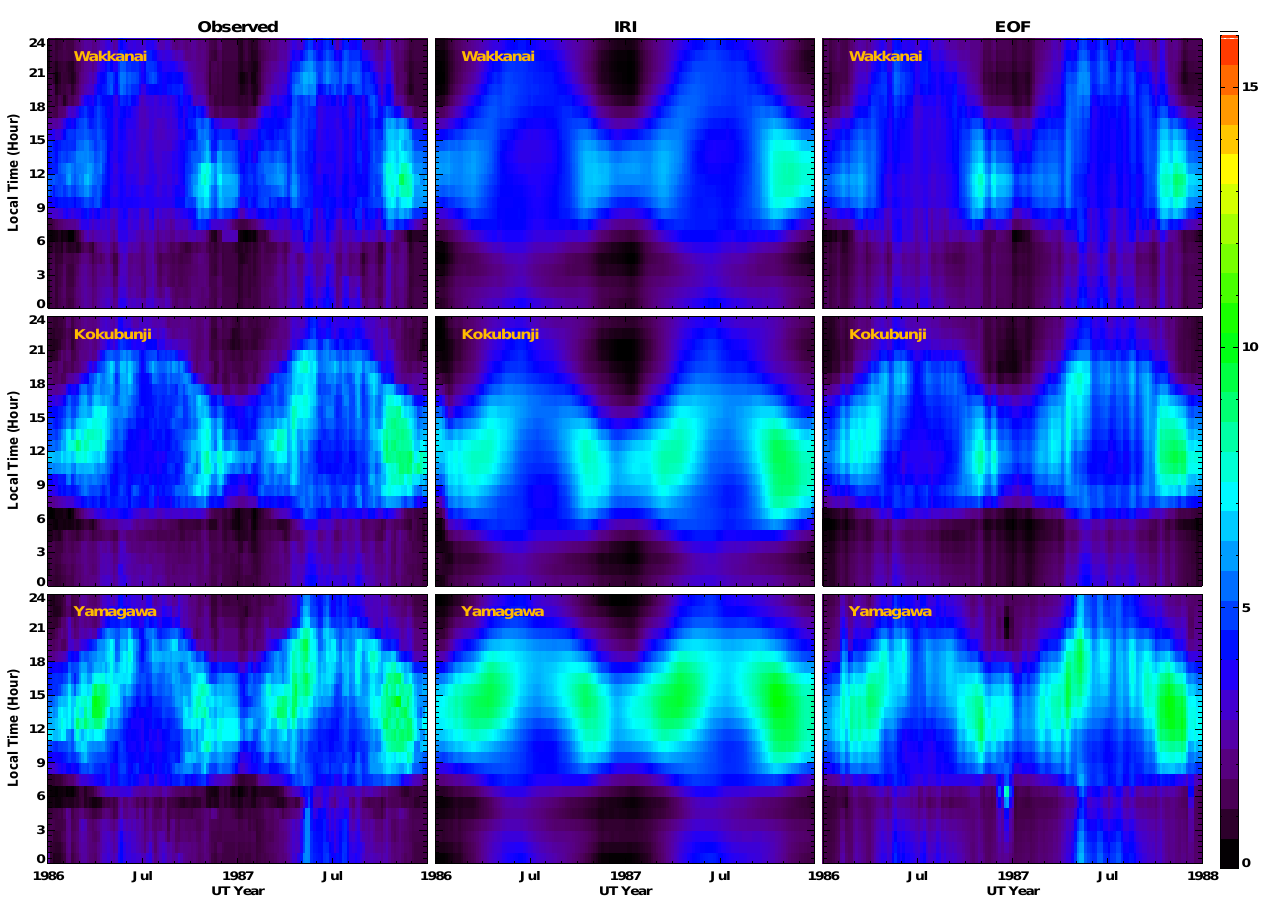
Fig. 7. Comparison among the observational fo F2, IRI model value and EOF model value during 1986–1988.